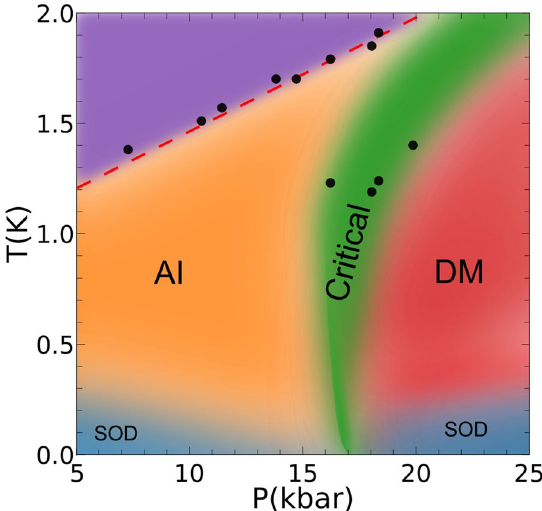
Fig. 4 Speculative phase diagram of the LAMT in tellurium. The violet area represents the area, where the chemical potential is not situated in the band. AI: Anderson insulator ( L s.o. > ξ L ). SOD: spin – orbit delocalization. DM: disordered metal. The green area represents the critical regime. The black circles mark the positions of the anomalies, which coincide with the temperature to which VRH and/or σ = σ 0 + A ⋅ T b is a good fi t. Thus, the red dashed line marks roughly the temperature at which we expect that the fermi level enters the localized states of the valence